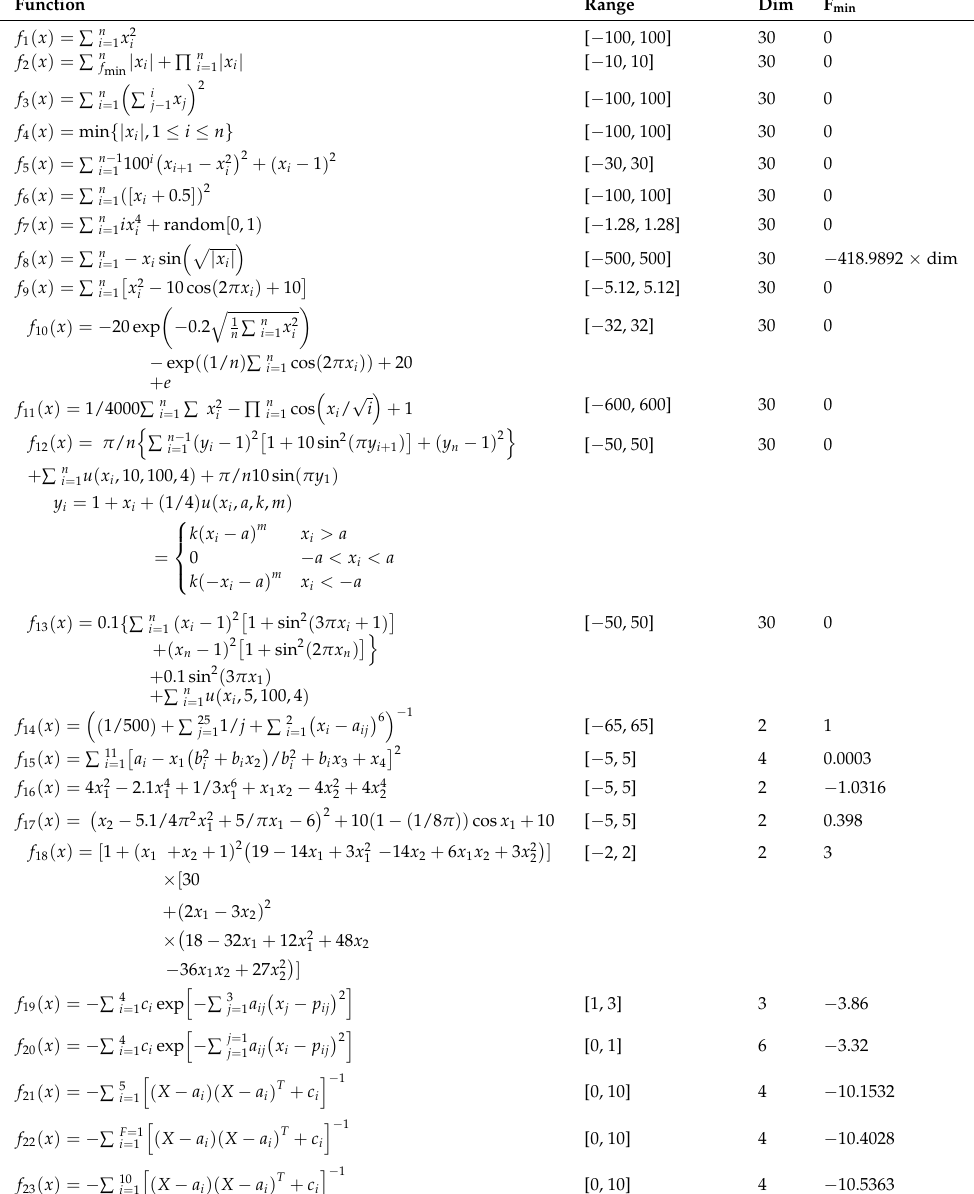
Table 2. Benchmark functions.